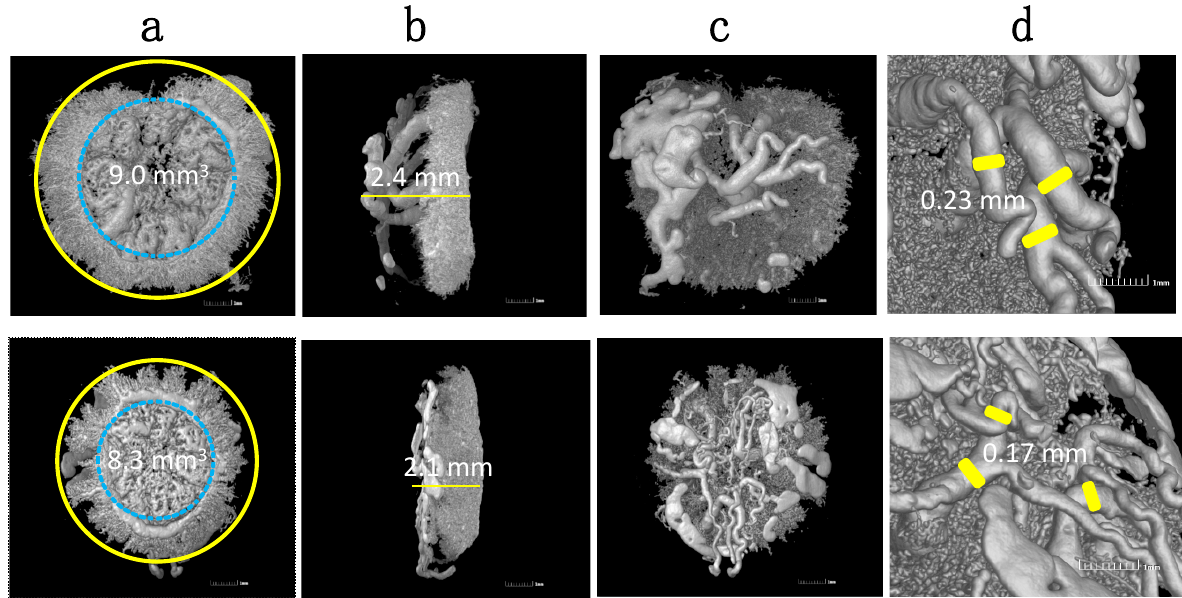
Figure 2. Representative 3D vascular castings of HO-1 Het (top panel) and WT (bottom panel) placentas harvested at E16.5 using MicroCT. Images show differences in: ( a ) circumferences; ( b ) thicknesses; ( c ) maternal vasculatures; and ( d ) spiral artery diameters. Modified from Zhao H, et al, Biol Reprod 2011 , 85 , 1005–1012 with permission.